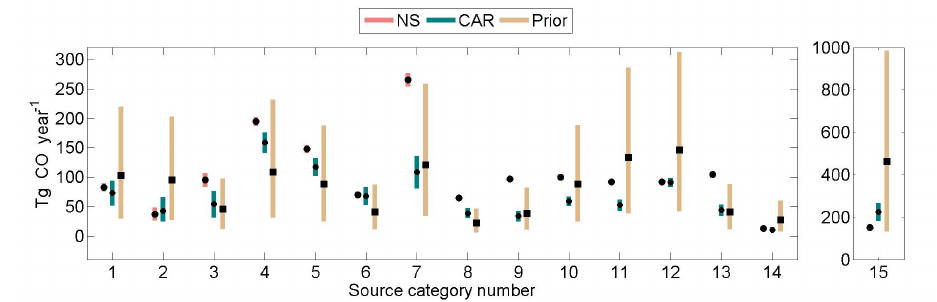
Fig. 12. Plots of 95% prior and posterior credible intervals for the real MOPITT data inversion. Posterior means for both models are marked with dots inside the corresponding intervals. The squares on the prior credible intervals represent the corresponding prior means. See Fig. 2 for definition of source category numbers.